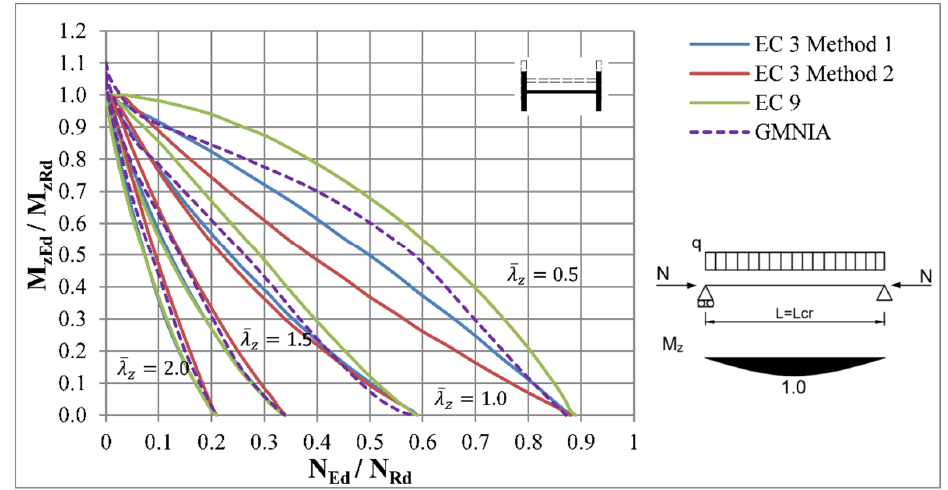
Figure 27. Interaction curves for weak axis flexural buckling of beam-columns with IPE 100 cross-section.